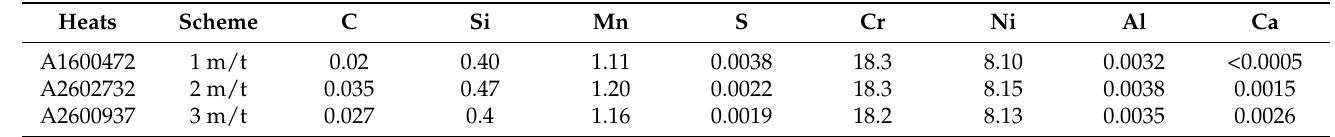
Table 5. Composition of finished steel sample in the tests where different amounts of CaSi wires addition (mass%).